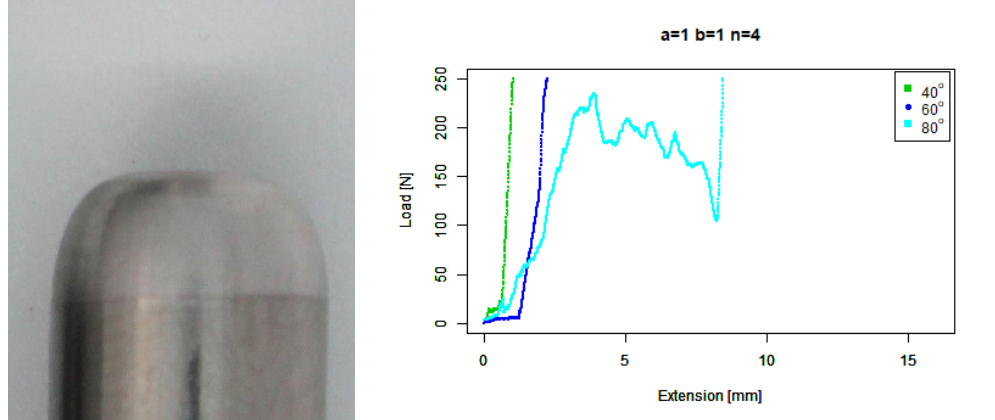
Figure 15. Basic squircle tip. ( Left ) Tip Profile. ( Right ) Experimental